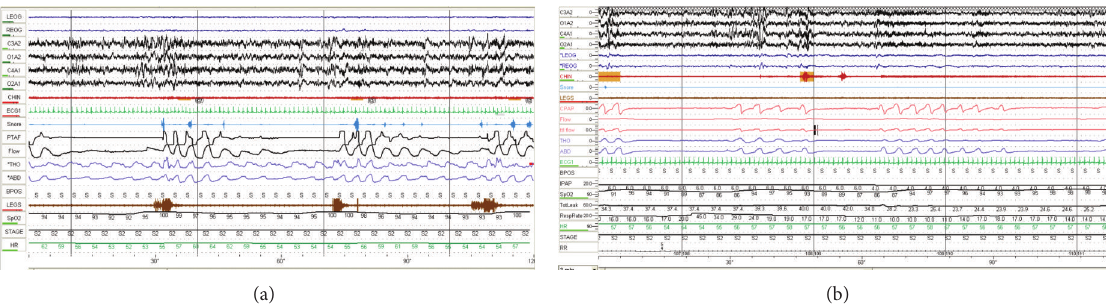
Figure 1: (a) Diagnostic polysomnogram showing obstructive events (arrows). Leads from top to bottom; eye, EEG, chin, ECG, snore, nasal pressure, thermal airflow, thoracic and abdominal effort, legs movement, saturation, and heart rate. (b) Development of central events on CPAP therapy (arrows). Leads from top to bottom; EEG, eye, chin, ECG, snore, legs movement, CPAP, flow, thoracic and abdominal effort, IPAP, saturation, leak, respiratory rate, and heart